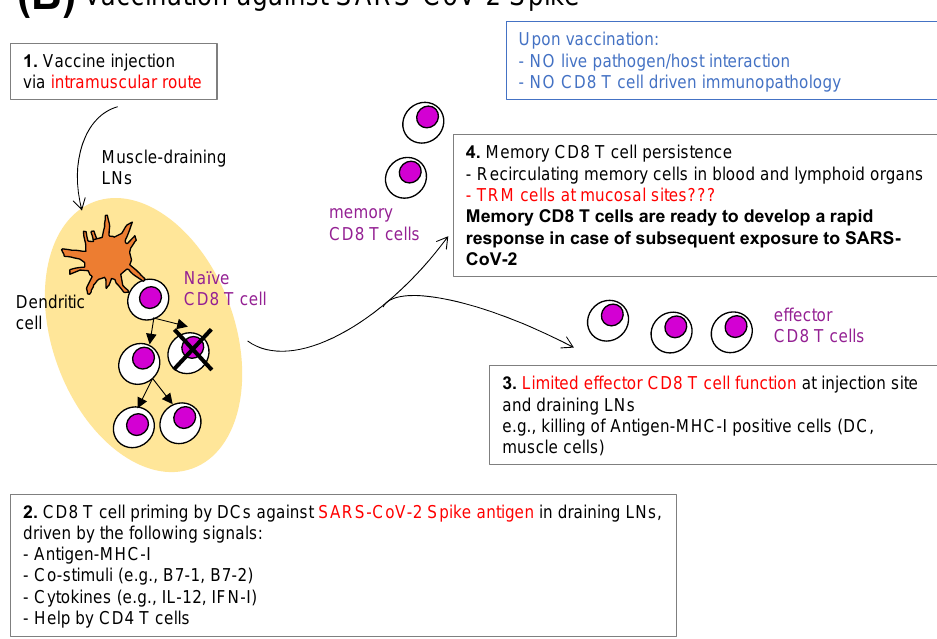
Figure 1. Anti-SARS-CoV-2 CD8 T cells: natural infection versus vaccination. ( A ) Infection with SARS-CoV-2. SARS-CoV-2 infection usually starts in the upper respiratory airways, with possible subsequent virus spreading to other organs ( 1 ). Priming of naïve CD8 T cells occurs in airway-draining lymph nodes (LNs), wherein mature dendritic cells (DCs) present epitopes from a series of SARS-CoV-2 antigens in the context of MHC-I molecules, together with ligands for costimulatory receptors, and in the presence of additional signals provided by helper CD4 T cells and cytokines ( 2 ). Primed CD8 T cells proliferate and differentiate, generating a progeny of CD8 T cells that migrate out of LNs and reach distant sites all over the body. Upon antigen – MHC-I recognition on the surface of SARS-CoV-2- infected cells in so-called target organs, short-lived effector CD8 T cells exert their function, e.g.,